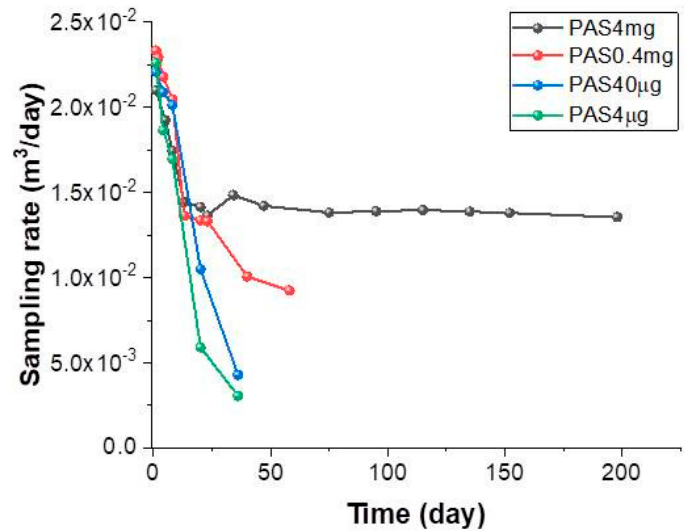
Figure 6. PAS sampling rate calculated for the samplers coated with di ff erent Au@TiO 2 masses and exposed to outdoor air for increasing periods (days).